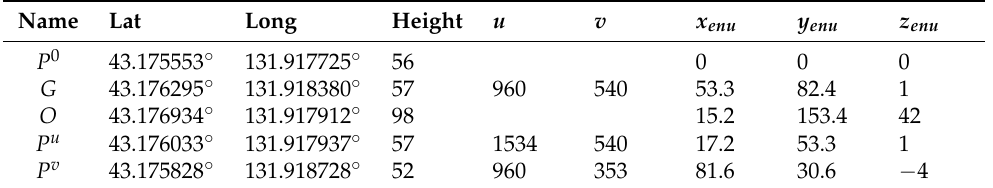
Table 1. The points used for the calibration. Latitude and longitude in degrees, altitudes and ENU coordinates in meters, coordinates of pixels in F im units ( u is the column index, v is the